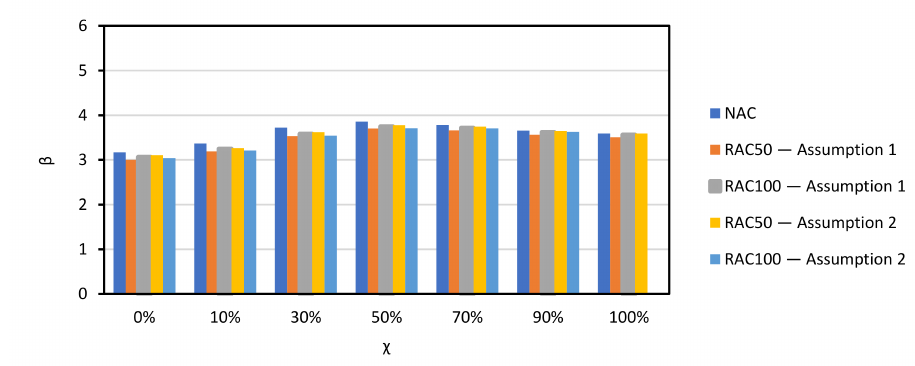
Figure 10. β vs. χ for both assumptions for θ R . EN1992 [31] and prEN1992 [32]. Results of